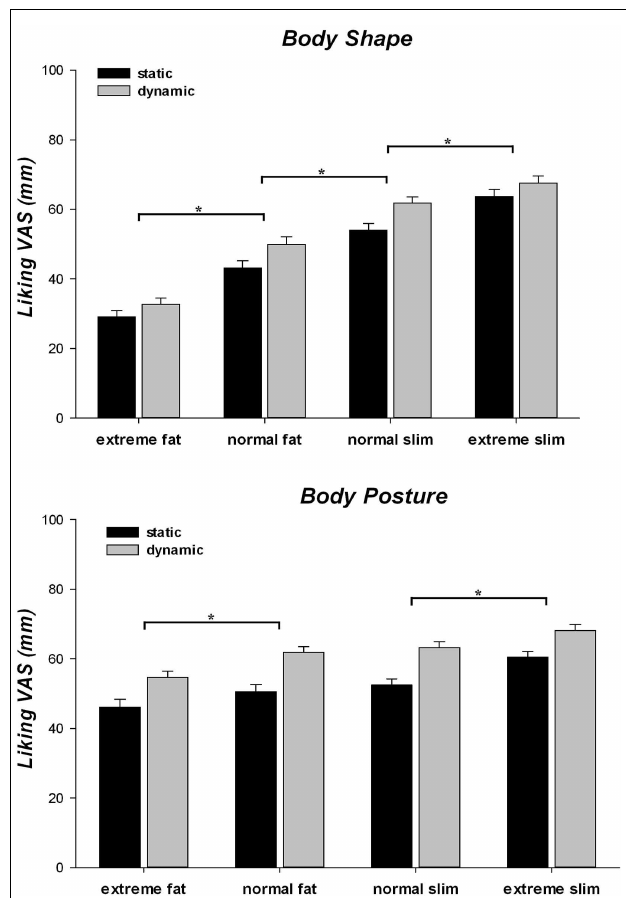
FIGURE 4 | Mean and standard error of mean for liking subjective rating of human models as a function of body shape and posture blocks, implied motion (static/dynamic) along the four categories of body weight (extreme fat/normal fat/normal slim/extreme slim). * p < 0.05.